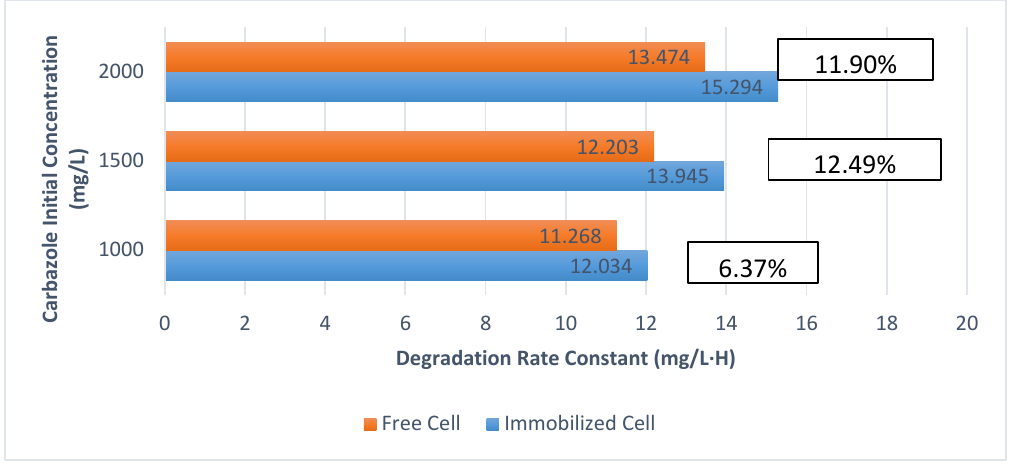
Figure 2. Degradation rate constant at 1000, 1500 and 2000 ppm in flask scale Table 2. Decrement of carbazole concentration from initial value (%) with difference initial concentration